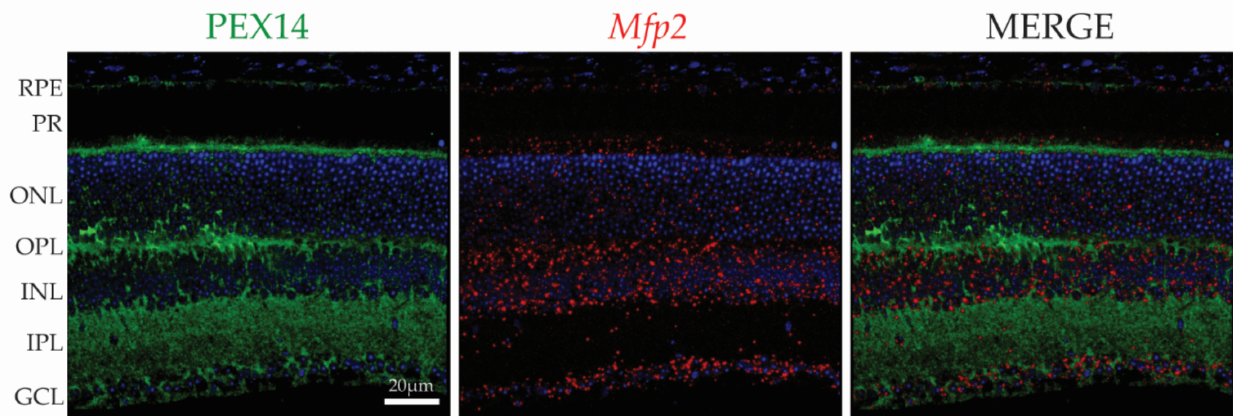
Figure 1. Spatial distribution of PEX14 protein and Mfp2 mRNA in the mouse retina. IHC for PEX14 (green) and RNAscope ® in situ hybridization for Mfp2 (red) reveals the presence of peroxisomes in the RPE, photoreceptors, interneurons and ganglion cells. Nuclei were counterstained with Hoechst (blue). PEX14, peroxin 14; Mfp2 , multifunctional protein 2; RPE, retinal pigment epithelium; PR, photoreceptor layer; ONL, outer nuclear layer; OPL, outer plexiform layer; INL, inner nuclear layer; IPL, inner plexiform layer; GCL, ganglion cell